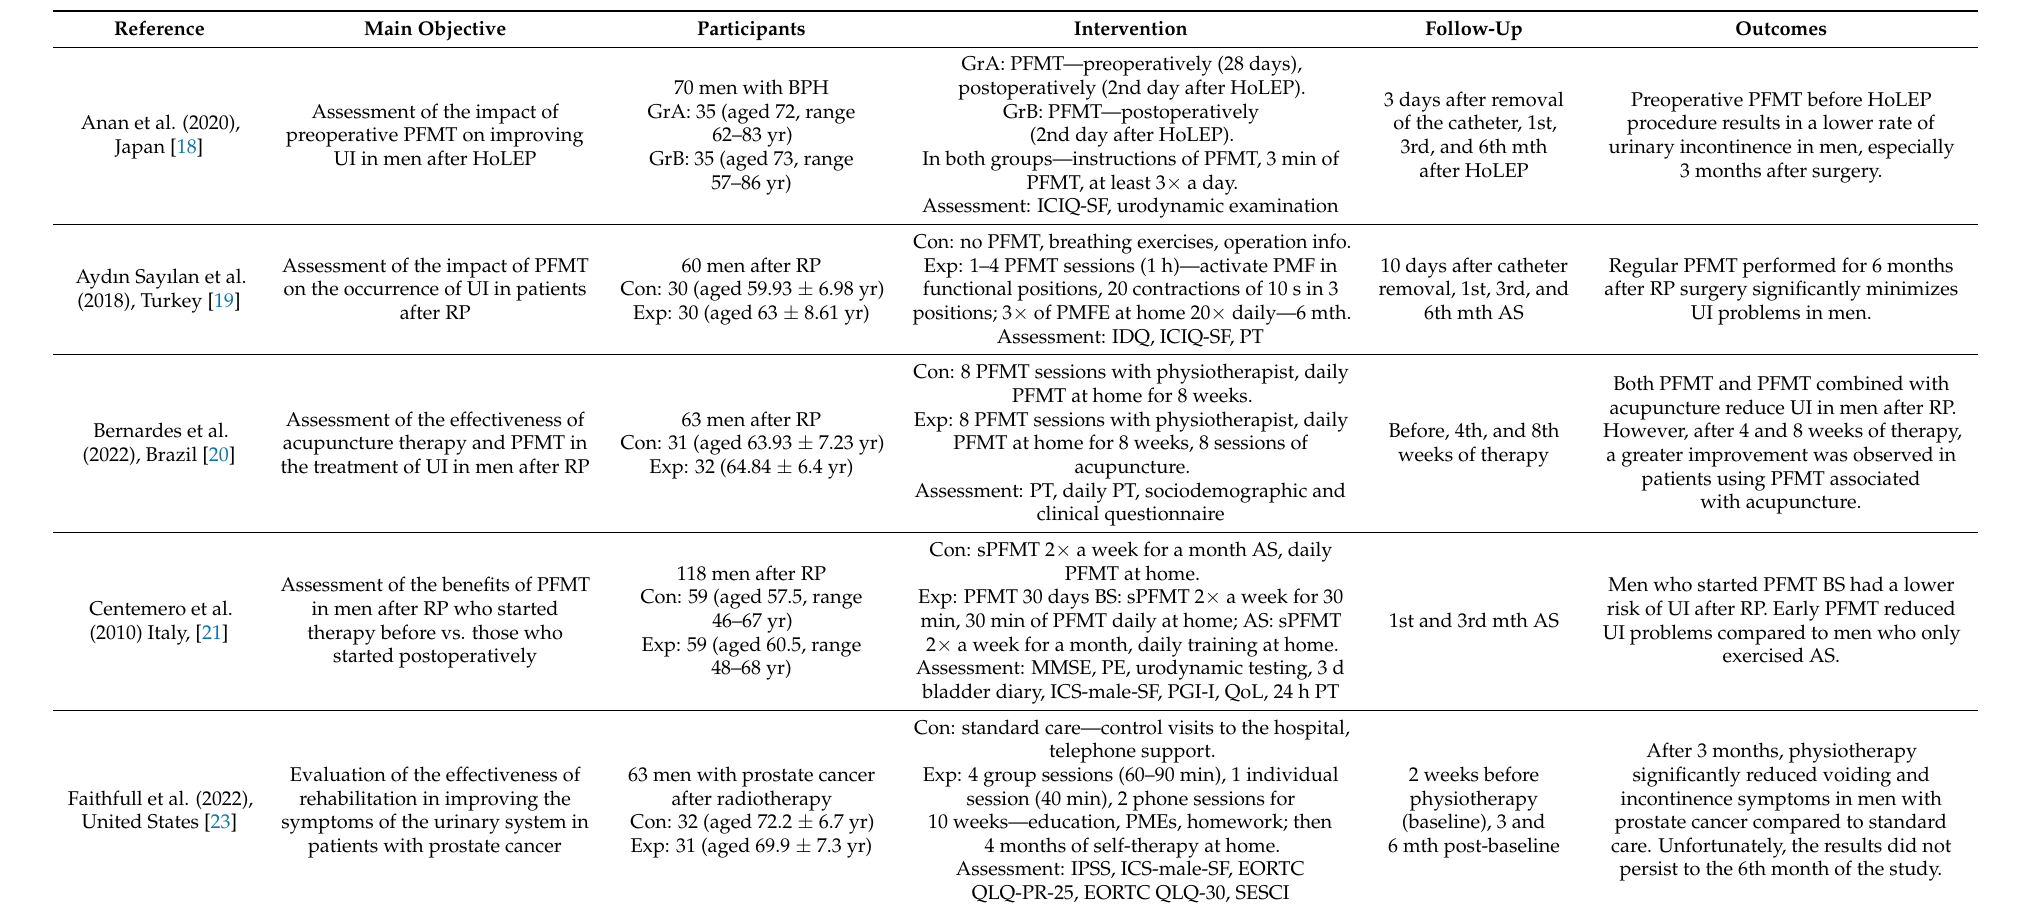
Table 2. PFMT in men with